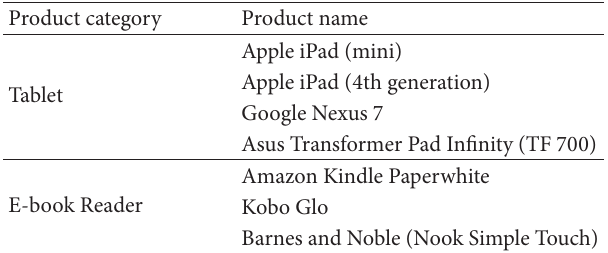
Table 2: Dataset description.